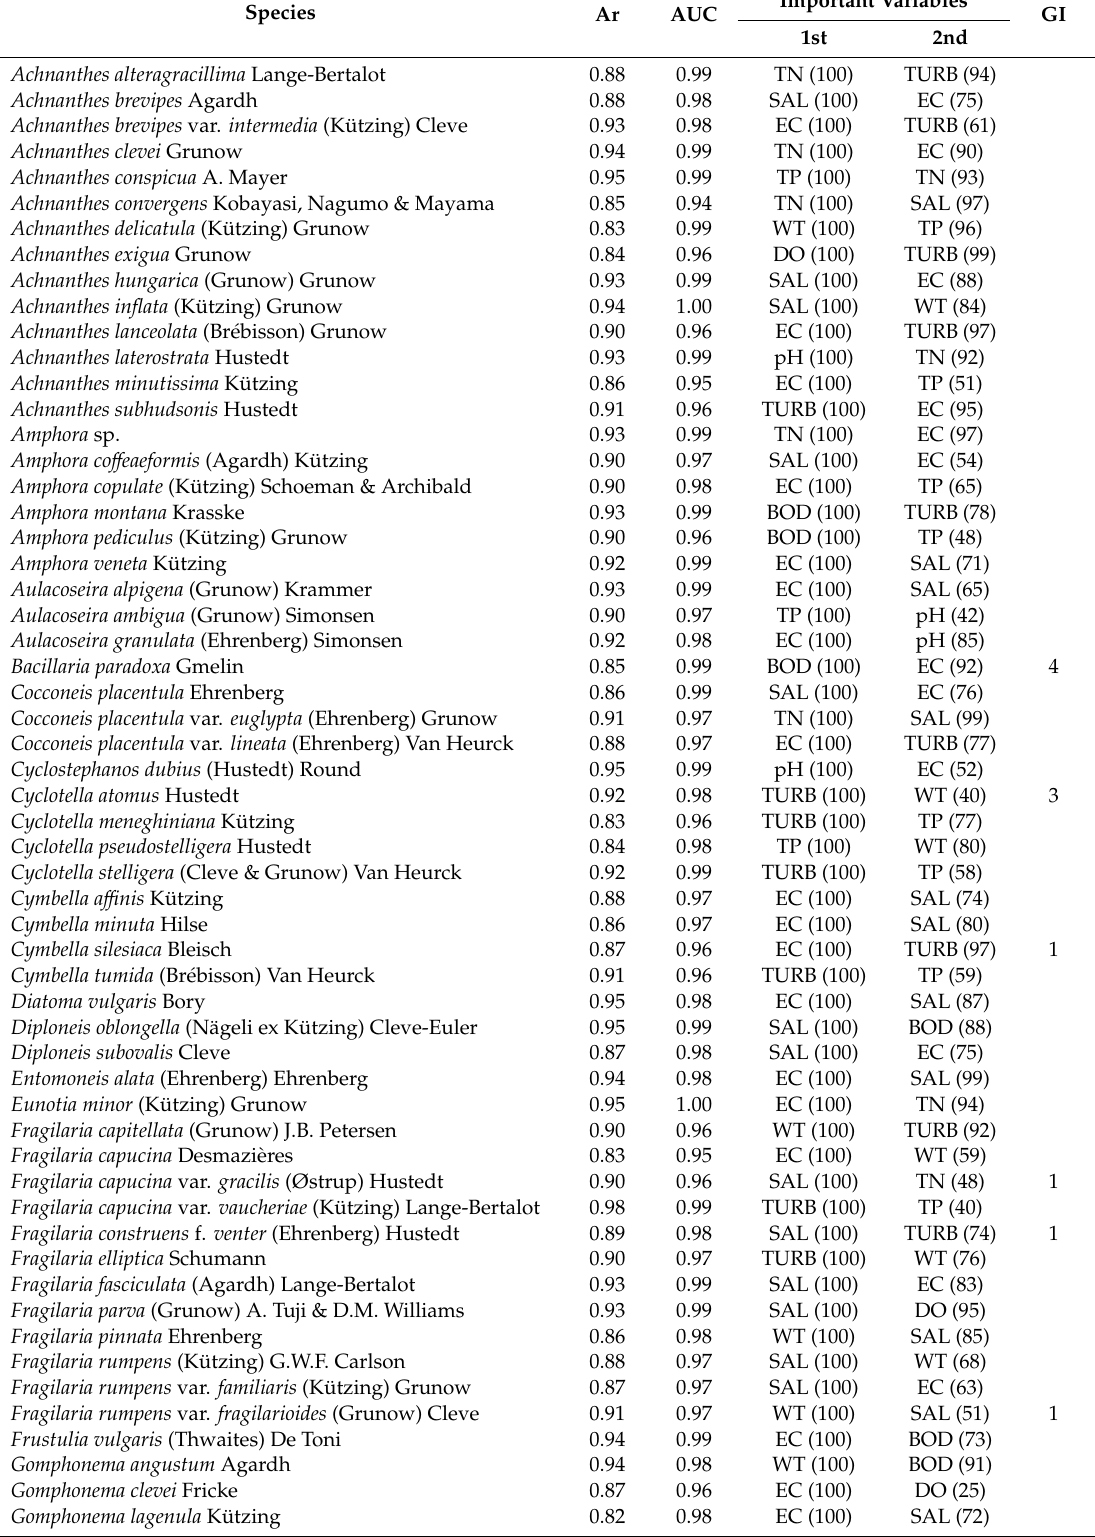
Table 5. List of epilithic diatoms with the first and second most important variables predicting species appearance by a random forest model in Korean estuaries between 2009 and 2016. Ar, accuracy rate; AUC, area under the curve; GI, group indicator. Species Ar AUC